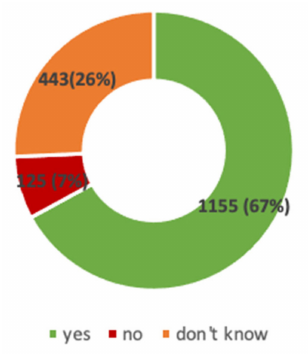
Figure 2. Attitude towards vaccination against